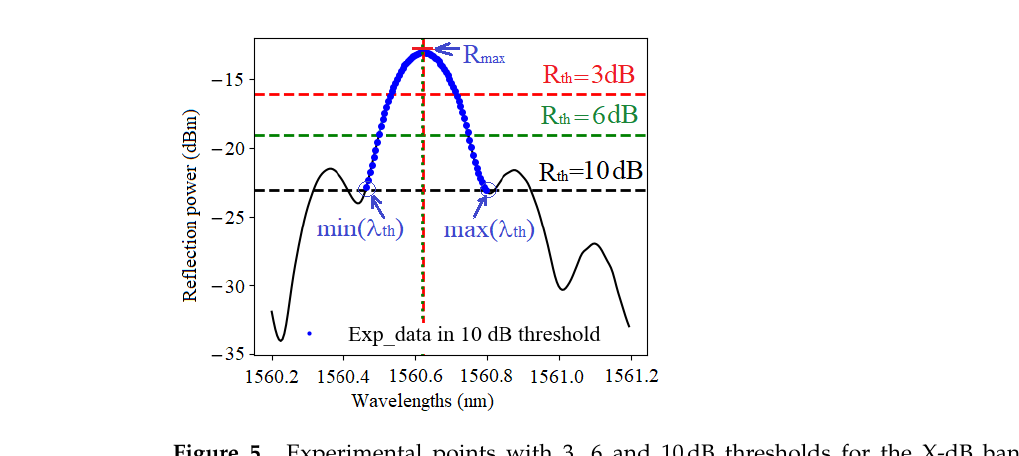
Figure 5. Experimental points with 3, 6 and 10dB thresholds for the X-dB bandwidth peak detection method.